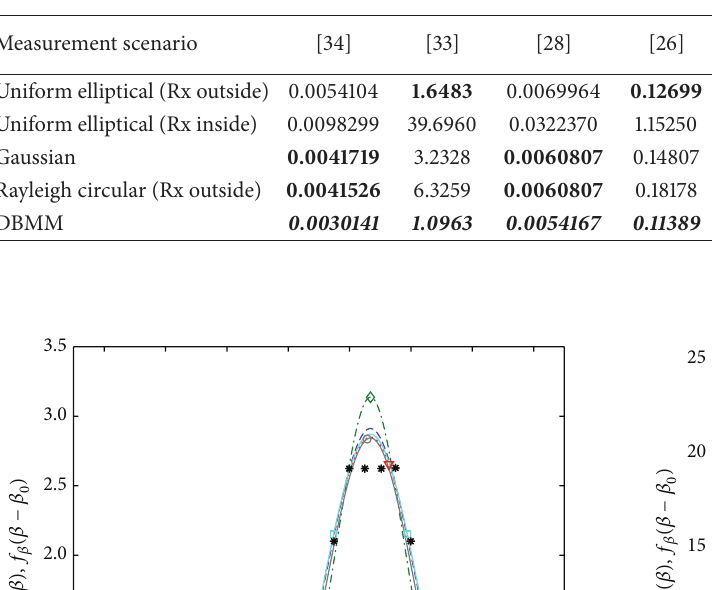
Table 7: LSE for selected models calibrated by empirical data.